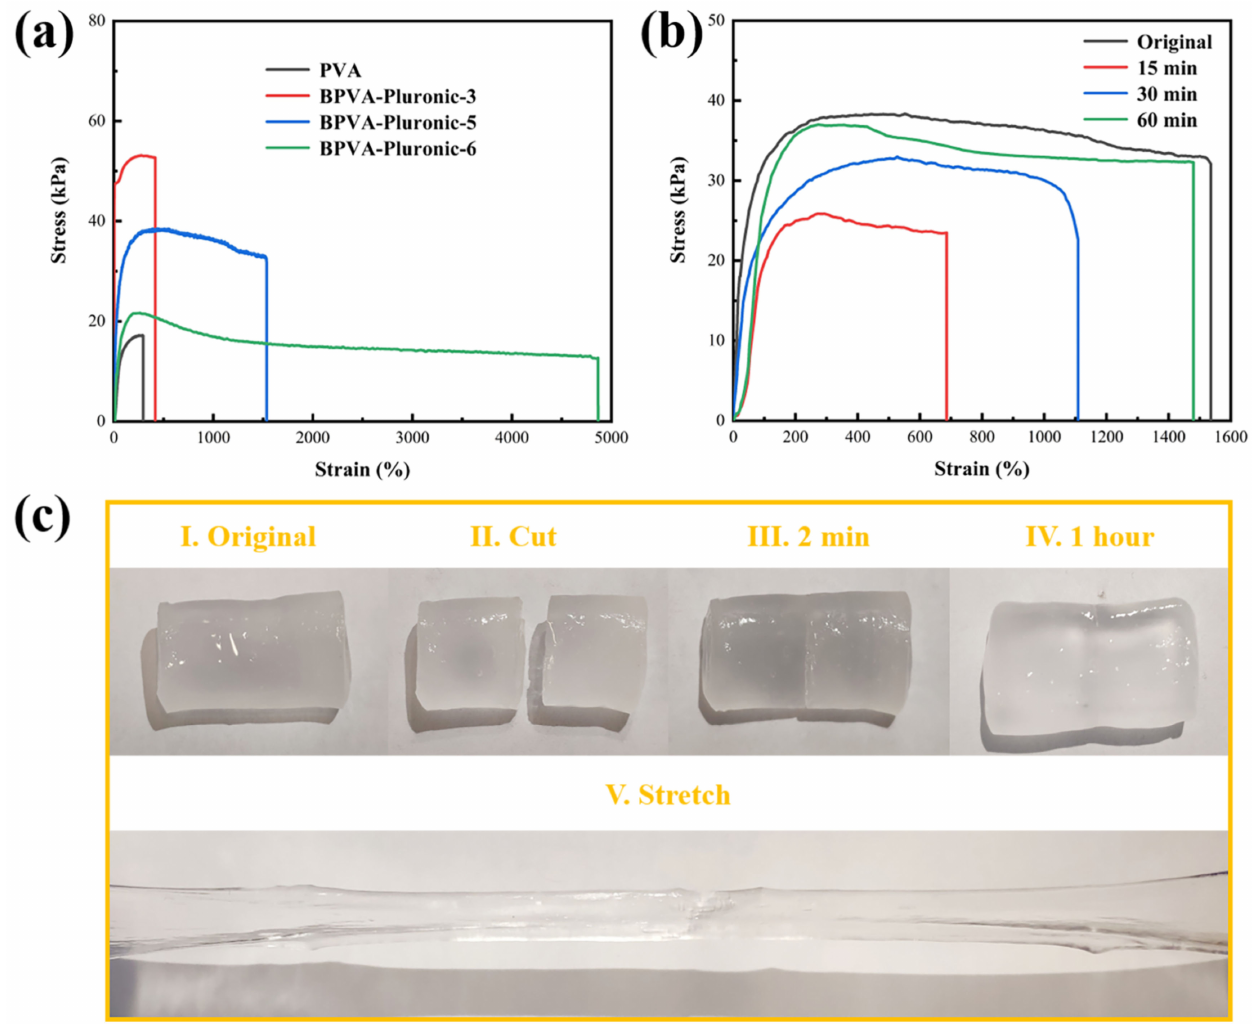
Figure 4. ( a ) Stress–strain curves of PVA hydrogel and BPVA-Pluronic hydrogels prepared from varied PVA/Pluronic ratio. ( b ) Stress–strain curves of the original BPVA-Pluronic-5 hydrogel and cut-healed BPVA-Pluronic-5 hydrogel for healing times of 15 min, 30 min and 60 min. ( c ) Digital photographs demonstrating the self-healing process of BPVA-Pluronic-5 hydrogel. I original state; II cut into two pieces; III self-healing in 2 min. IV self-healing in 1 h. V stretching after